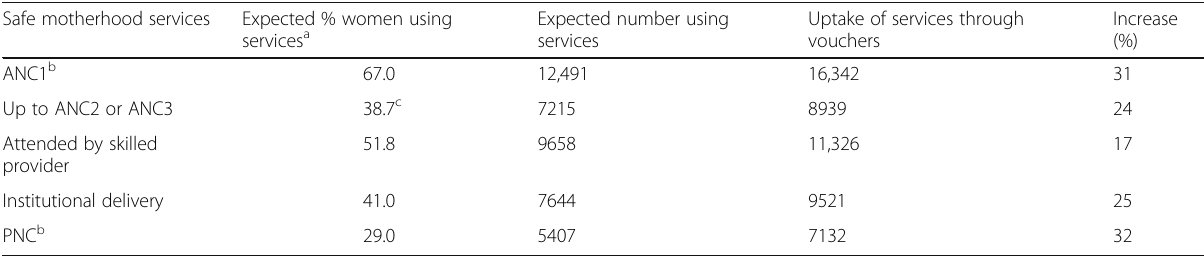
Table 2 Expected uptake of safe motherhood services compared with uptake through vouchers, Lahj, 2014 Safe motherhood services Expected number using